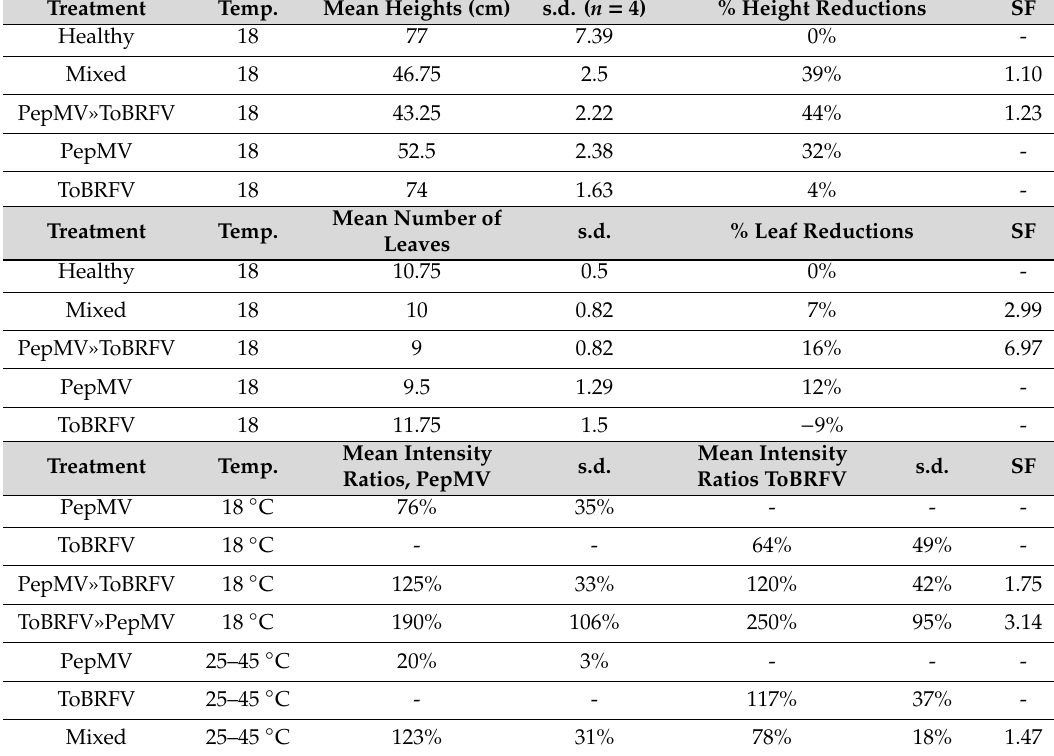
Table 4. Synergy factor of tomato brown rugose fruit virus (ToBRFV) and pepino mosaic virus (PepMV) co-inoculation e ff ects on tomato plant heights and total viral load. Treatment